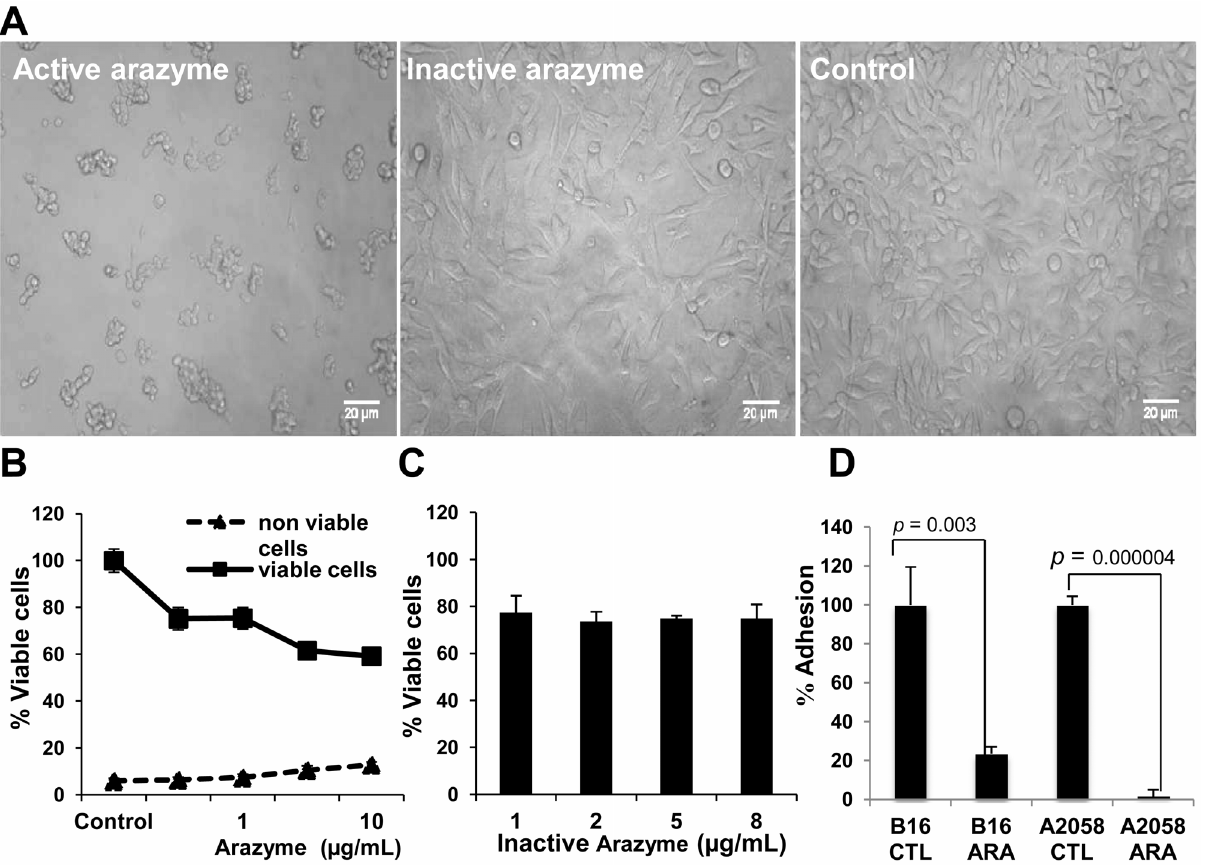
Figure 3. Active but not heat-inactivated arazyme has a cytostatic effect on murine melanoma B16F10-Nex2 cells. ( A ) Representative images of tumor cells treated for 24 hours with 8 m g/mL of active or heat-inactivated arazyme. Control, untreated cells. ( B ) B16F10-Nex2 cells were cultured for 72 hours, and different concentrations of active arazyme (0.5, 1, 5 or 10 m g/mL) were added on 0, 24 and 48 hours time points. The supernatant was carefully removed after plate centrifugation (10 min, 2,500 rpm) and fresh culture medium without arazyme was added. After 24 hours, cells were counted in presence of Trypan blue and the percentage of viable and non-viable cells was calculated compared to untreated control. ( C ) Tumor cells were treated with increasing concentrations of heat-inactivated arazyme for 48 hours. Viable cells were counted in presence of Trypan blue. ( D ) B16F10-Nex2 and A2058 cells (5 6 10 4 cells/well) were treated with arazyme (10 m g/mL) for 1 hour, plated on 96-wells plate, and after incubation for 3 hours, non-adherent cells were removed by a PBS rinse and adherent cells were stained. Data are representative of three independent experiments. p values are shown in the figure.